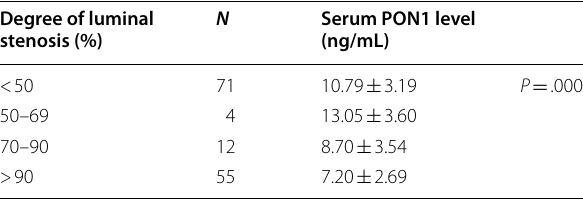
Table 6 PON1 levels of the study sample according to the degree of coronary vascular stenosis